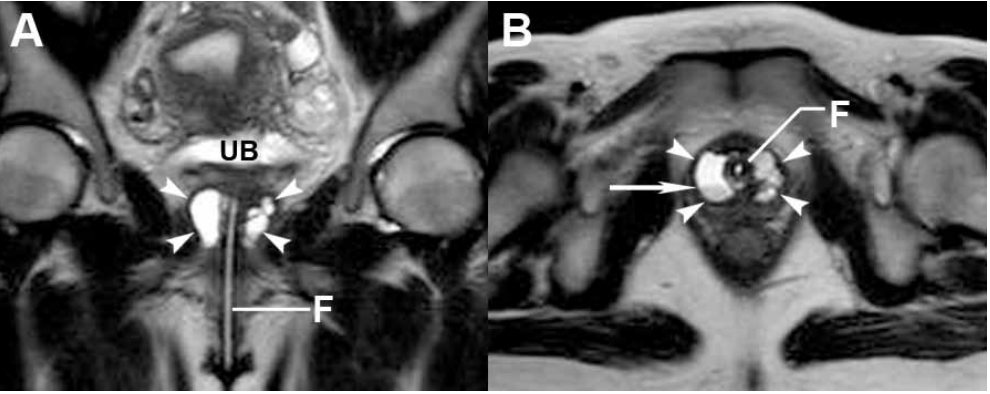
Figure 2 - (A) Coronal and (B) axial T2-weighted MR images demonstrated a circumferential high-signal intensity, fluid-filled lesion (arowheads) with fluid-debris level (arrow) and confirmed the diagnosis of urethral diverticulum. F=Foley catheter ; uB=urinary